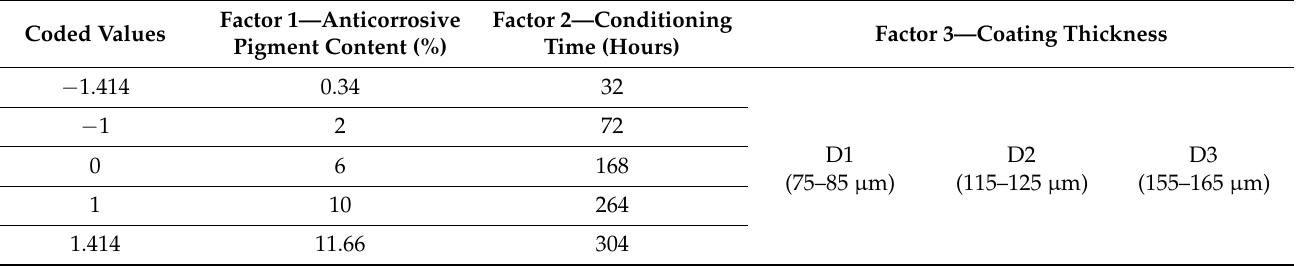
Table 1. Coded values of the experiment